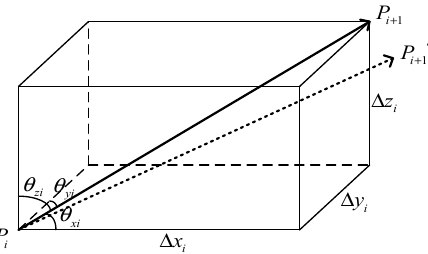
Figure 1. Diagram of a single growth iteration of an axon.